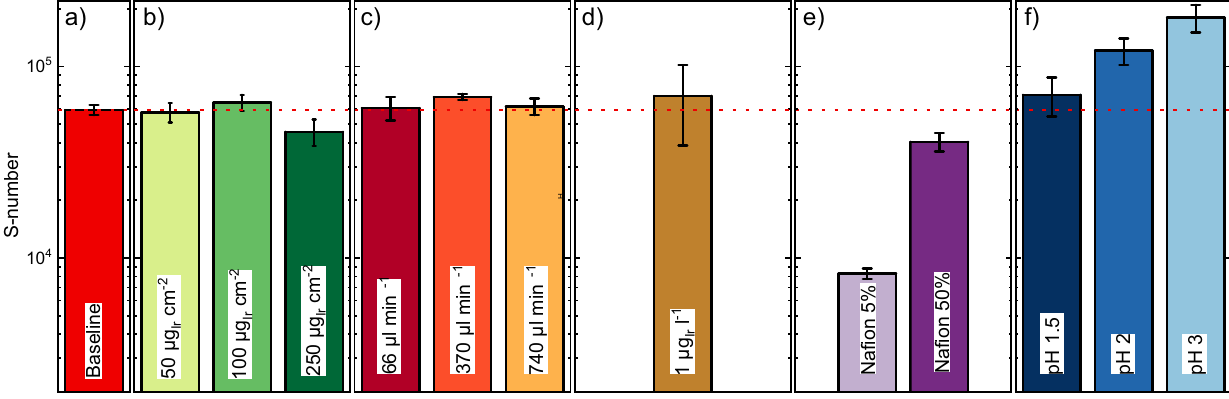
Fig. 3 S-numbers of IrO x catalyst spots with varied conditions, measured in SFC-ICP-MS. a Baseline measurement. b Variation of loading. c Variation of fl ow rate. d Addition of pre-dissolved iridium in the electrolyte. e Variation of Na fi on content in the catalyst layer. f Variation of pH. Red, dashed line: baseline measurement (10 µ g Ir cm − 2 catalyst loading, 200 µ l min − 1 fl ow rate, fresh electrolyte, 33 wt% Na fi on in the catalyst layer and 0.1 M H 2 SO 4 (pH = 1)), displayed for ease of comparison between b and f . Error bars were calculated as the standard deviation of at least three independent measurements. Source data are provided in the source data fi